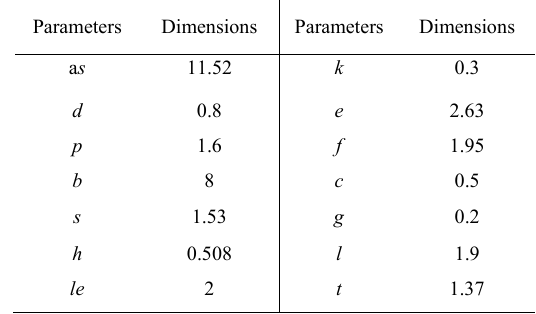
FIGURE 5. SIW engraved with two C-HMC real and imaginary parts of effective refractive